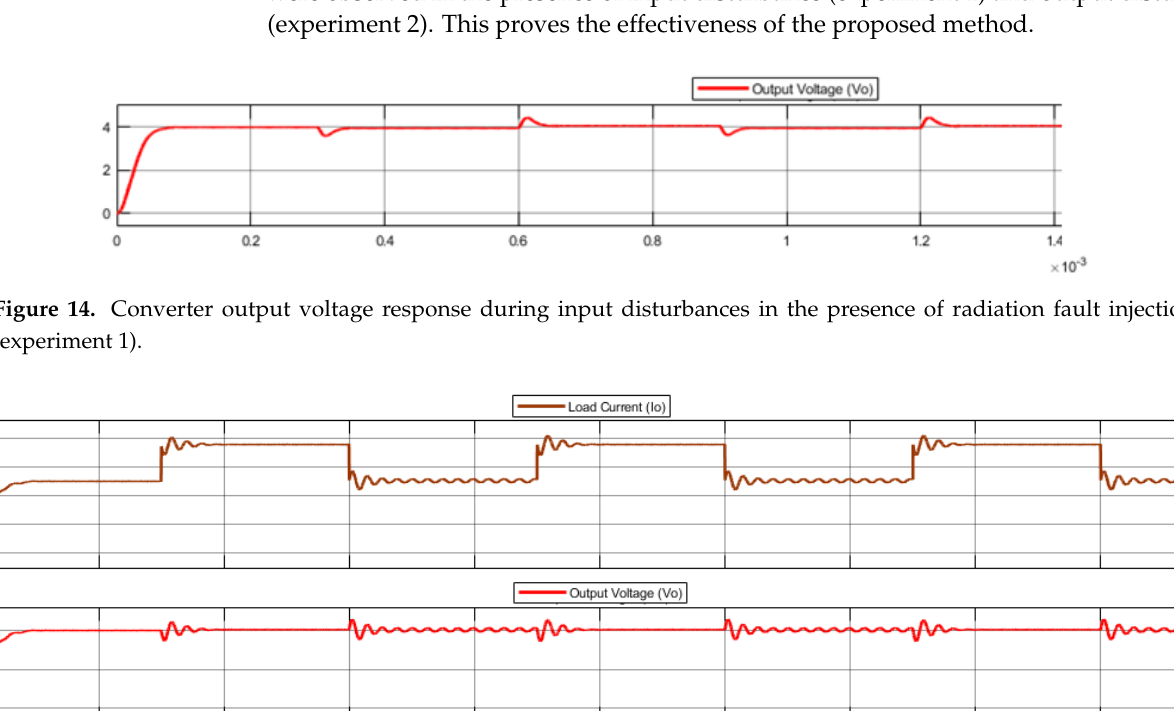
Figure 13. Schematic after synthesis showing the location of the insertion of bit-flip synthesizable fault models.